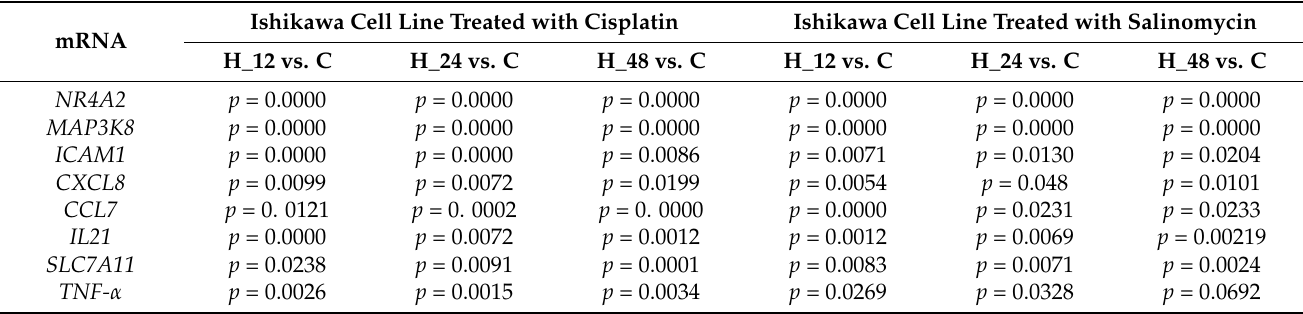
Table 4. Expression profiles of miR ‐ 30a ‐ 5p, miR ‐ 302e, miR ‐ 144 ‐ 3p, and miR ‐ 140 ‐ 3p in an endome ‐ trial cancer cell line exposed to cisplatin or salinomycin, compared to the control.